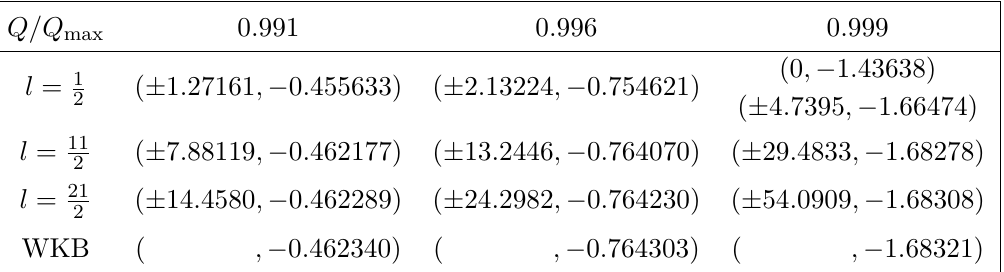
Table 2 . The low-lying QNMs !